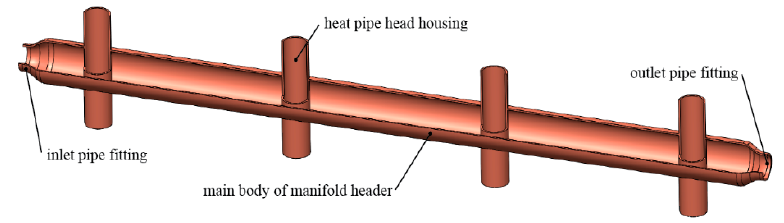
Figure 4. Partial section view of the commercially available manifold header.